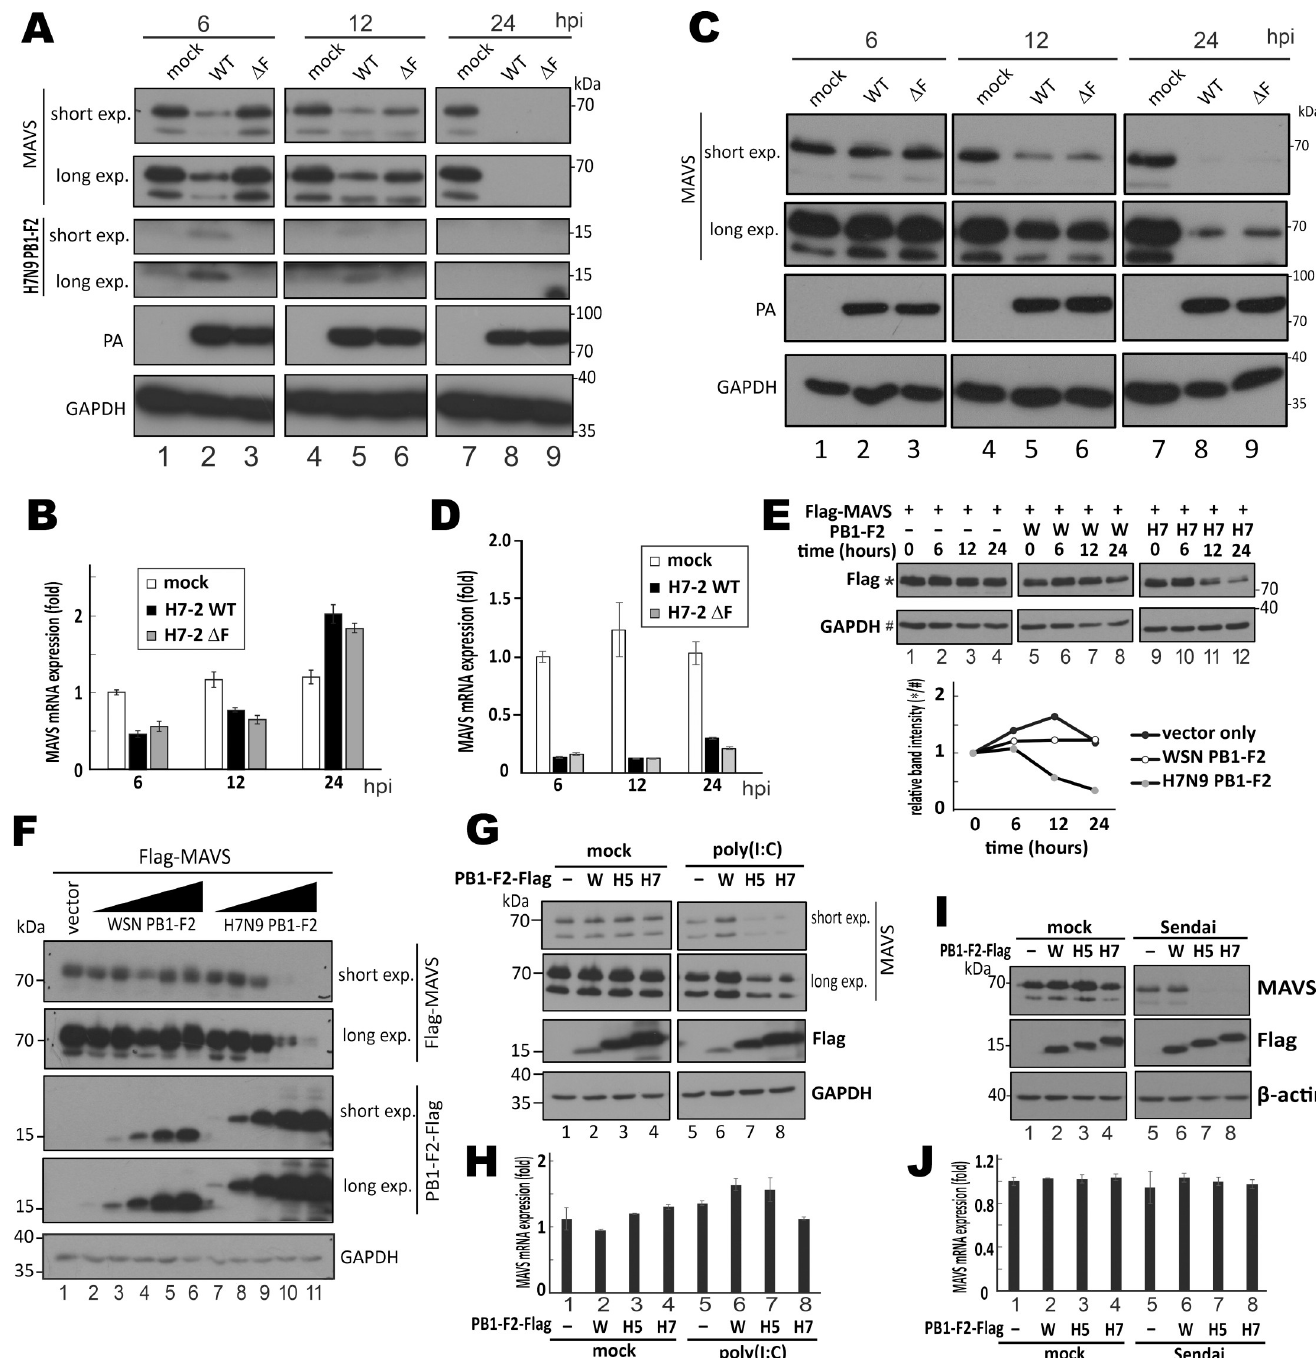
Fig 5. Facilitation of MAVS degradation by H7N9 PB1-F2 in immune-stimulated cells. ( A and B ) Impact of H7N9 PB1-F2 on MAVS protein level. THP-1 cells were infected with H7-2 WT and H7-2 Δ F viruses at MOI = 1. At 6, 12, and 24 hpi, infected cells were harvested for total protein extraction, SDS-PAGE and Western blot analysis with anti-MAVS and anti-H7N9 PB1-F2 (A). PA and GAPDH served as normalization controls for viral infection and loading. Harvested cells were also subjected to RT-qPCR analysis of MAVS mRNA level relative to that of GAPDH mRNA using comparative Ct method (B). ( C and D ) Impact of WSN PB1-F2 on MAVS protein level. THP-1 cells were infected with WSN WT and WSN Δ F viruses at MOI = 1. MAVS protein and mRNA were analyzed as above. ( E ) HEK293T cells in 6-well plates were co-transfected with 1 μ g pEF-Bos-Flag-MAVS and 0.2 μ g PB1-F2 expression constructs. After 24 hours, 100 μ g/mL cycloheximide (CHX) was added. Cells were harvested for total protein extraction at 0, 6, 12 and 24 hours after drug treatment for SDS-PAGE followed by Western blot analysis with anti- Flag. Relative band intensity of MAVS over GAPDH was plotted in the lower panel. ( F ) HEK293T cells were transfected with 0.5 μ g pEF-Bos-Flag-MAVS together with increasing dosage of expression construct for PB1-F2-Flag of WSN and H7N9 (0, 0.25, 0.5, 1, 1.5 and 2 μ g). After 48 hours, cells were harvested for total protein